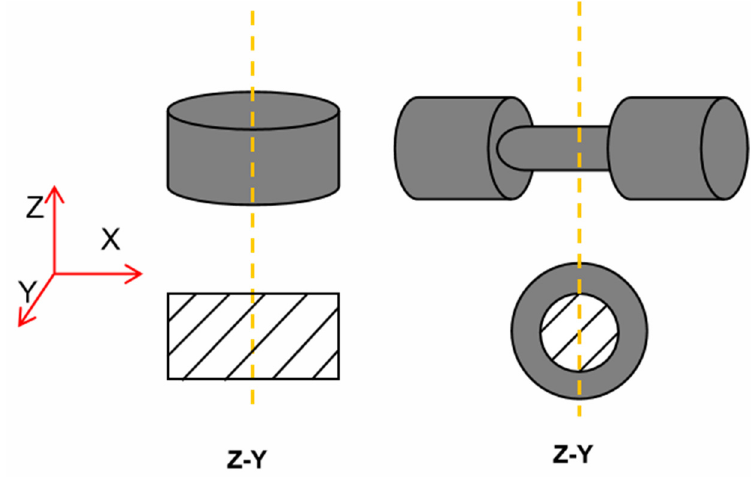
Figure 8. Section cutting diagram.